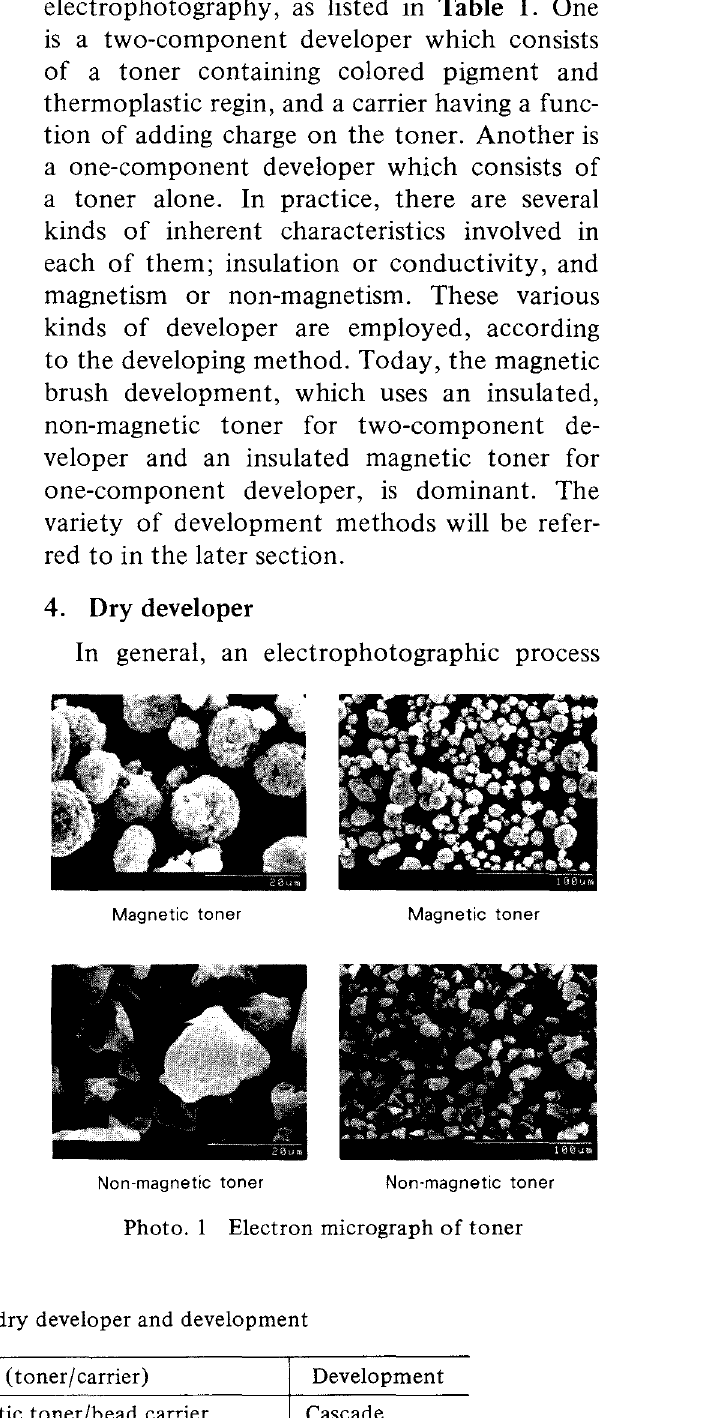
Table 1 Classification of dry developer and